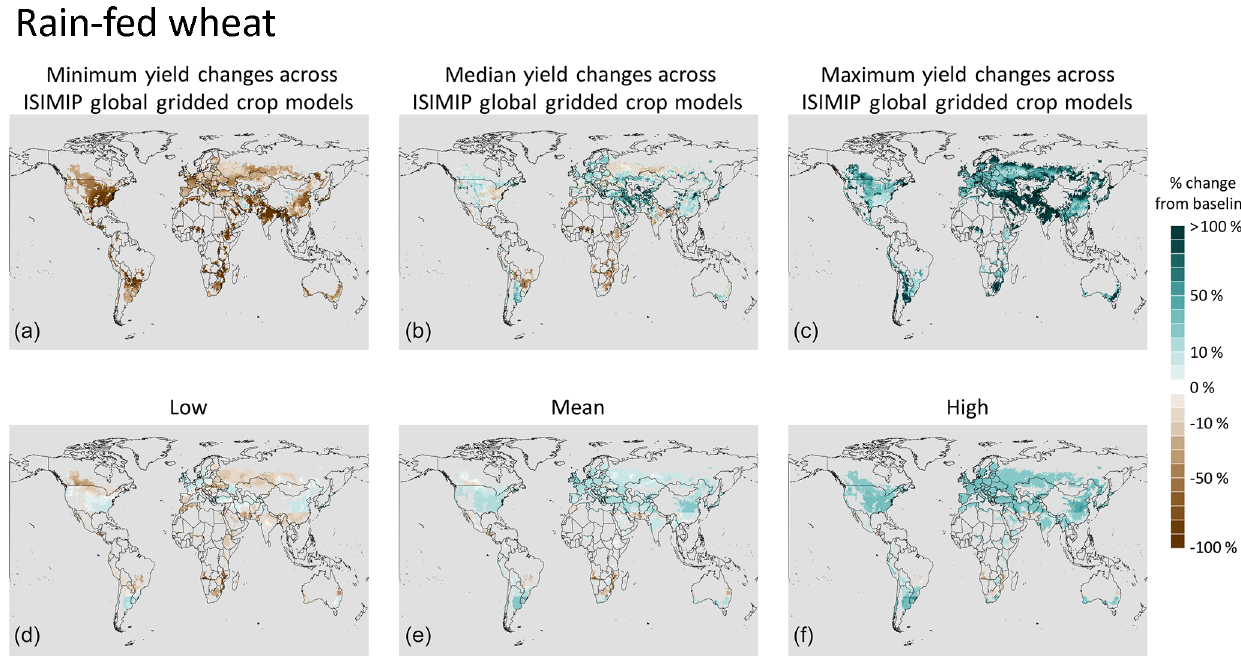
Figure 15. (a, b, c) Grid-cell-specific minimum (a, d) , median (b, e) , and maximum (c, f) yield change across the ISIMIP GGCMs for rain-fed wheat. (d, e, f) The low, mean, and high Persephone v1.0 yield changes in each grid cell for rain-fed